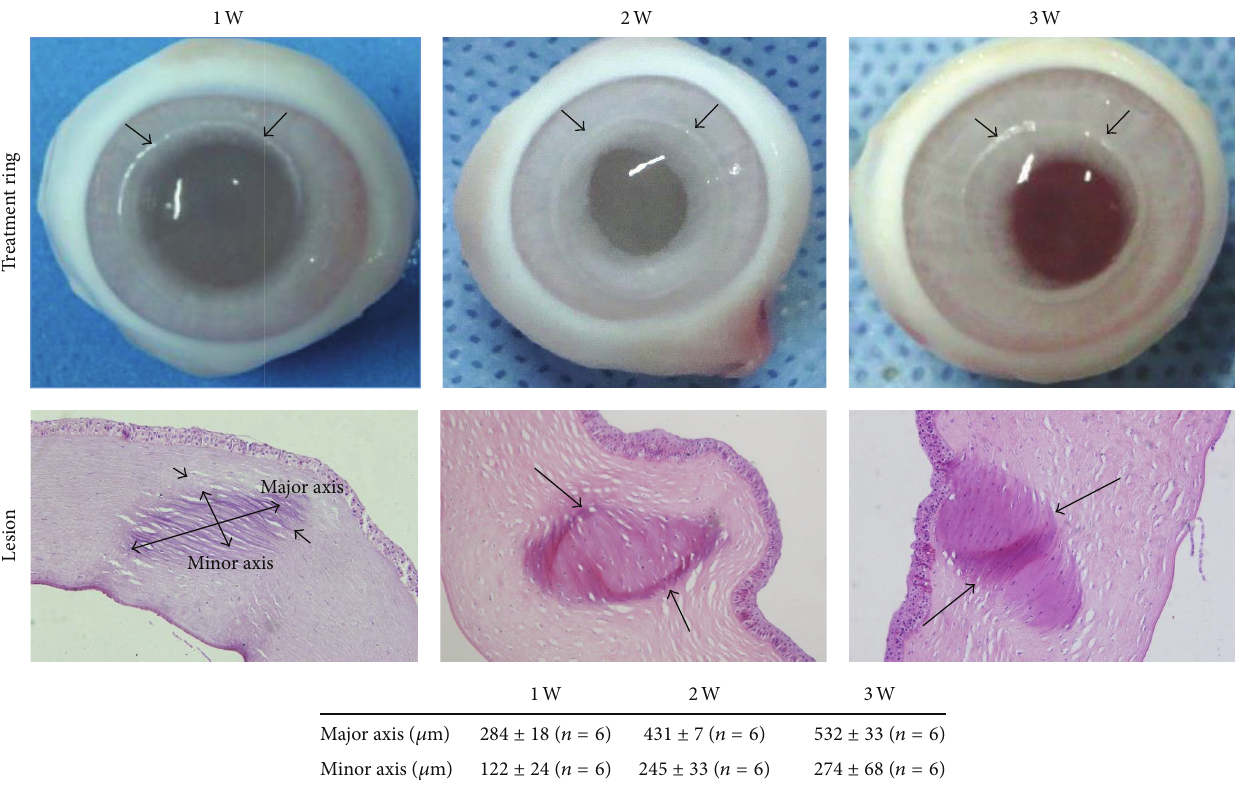
Figure 3: Photograph display of treatment ring in the rabbit cornea after HIFU keratoplasty treatment and photomicrograph of a rabbit cornea cross section after HIFU treatment. The loose stromal area (lesion) corresponds to a region of HIFU-induced collagen shrinkage, × 200. The table displays the major and minor axes of the oblique elliptical